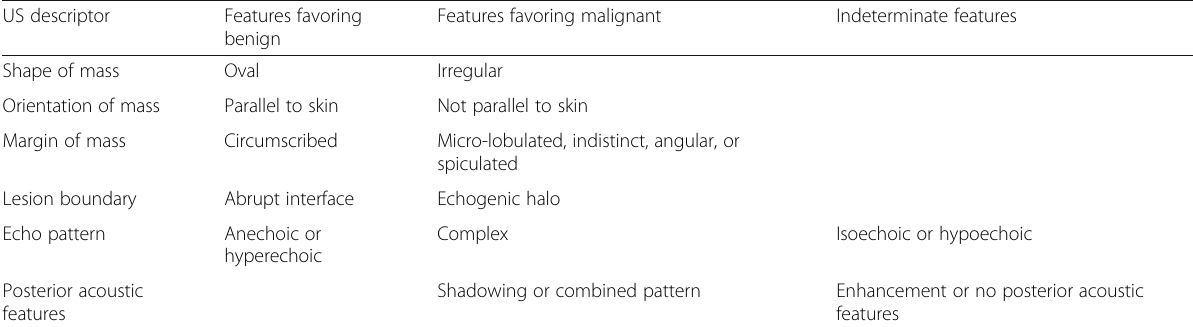
Table 2 BI-RADS US descriptors